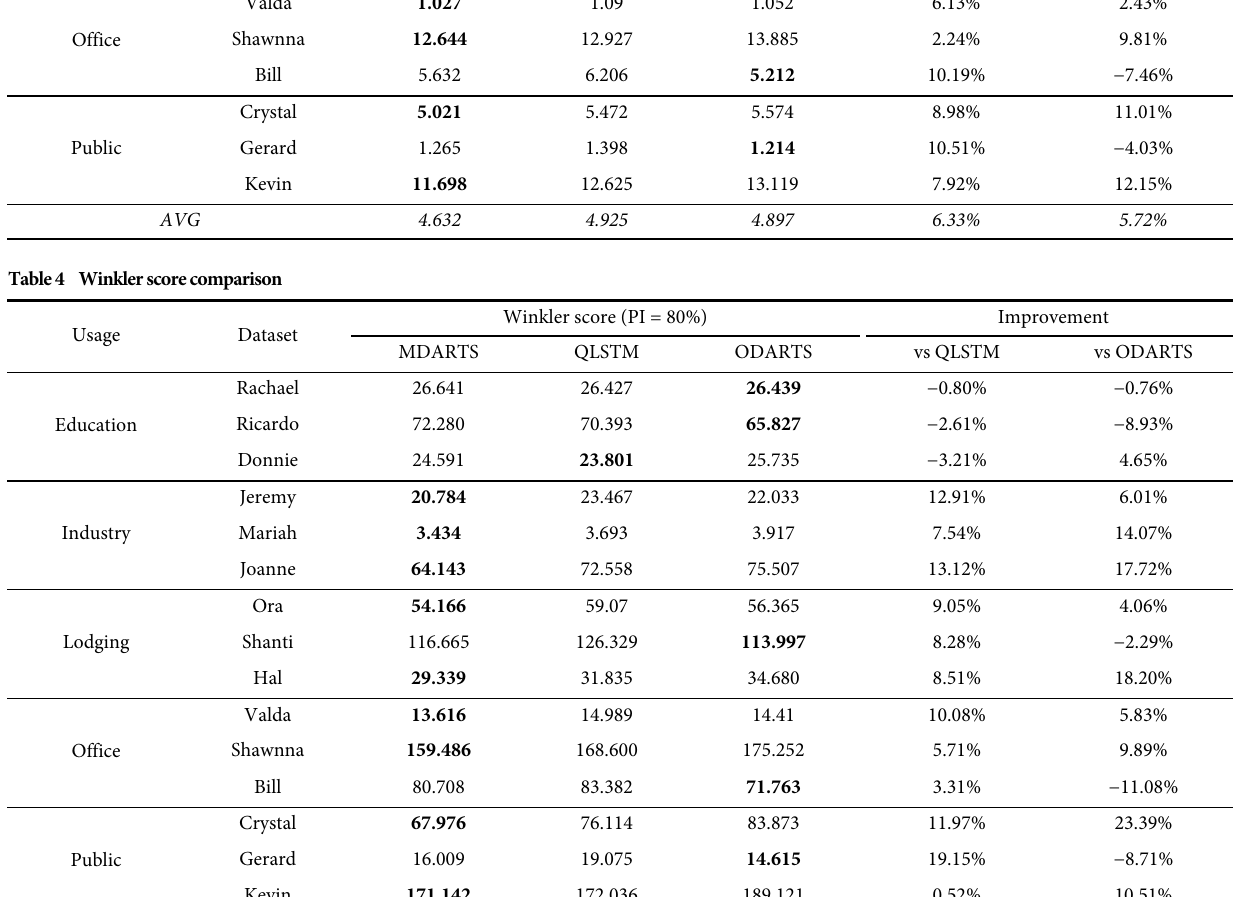
Table 3 Quantile score comparison Usage